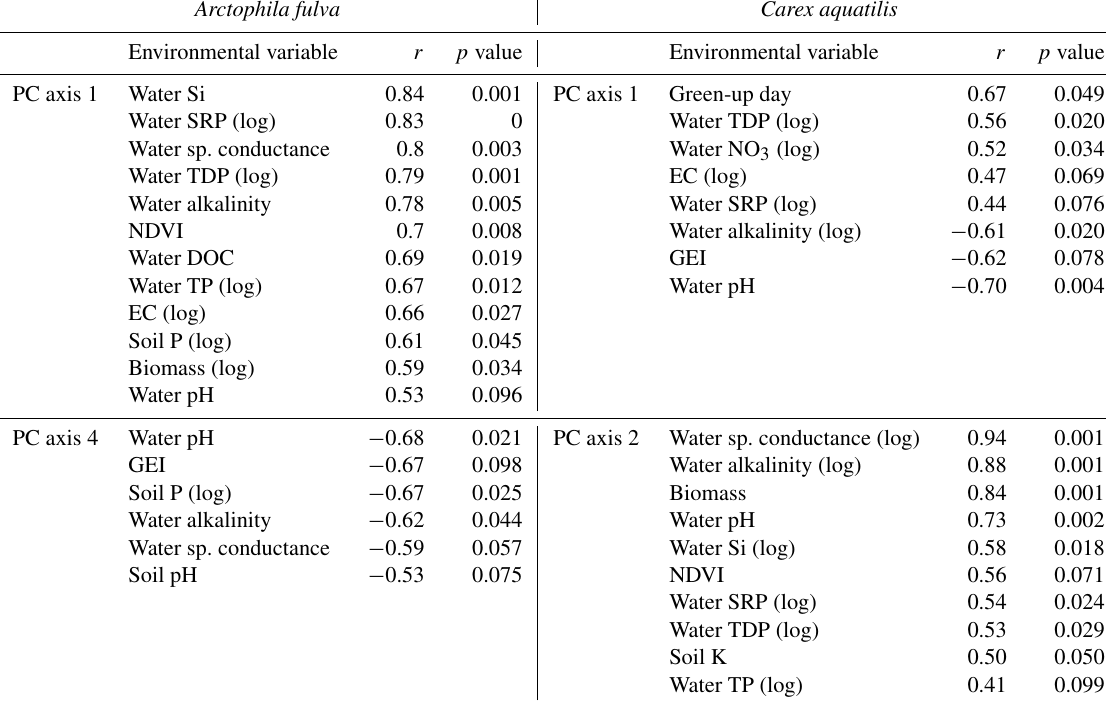
Table 3. PC axis correlations with environmental